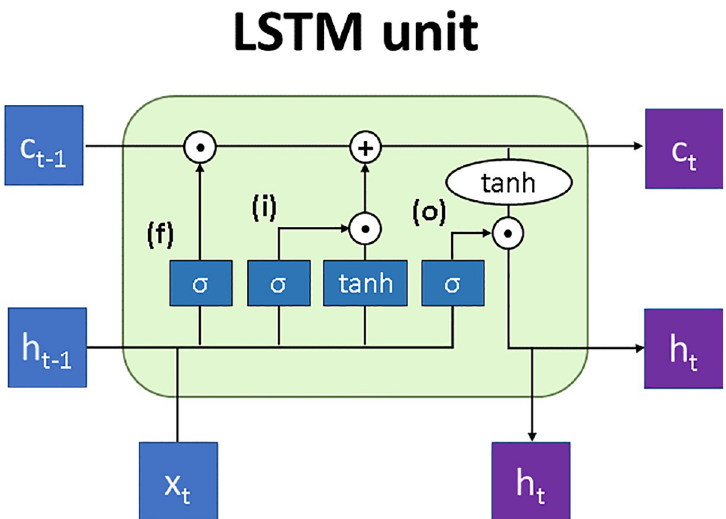
Fig 2. LSTM unit. Graphical representation of an LSTM unit at timepoint t, where c and h represent the cell state and hidden state respectively, x represents the input features at the current timepoint, and f, i o are the forget, input and output gates controlling the information passed on to the cell